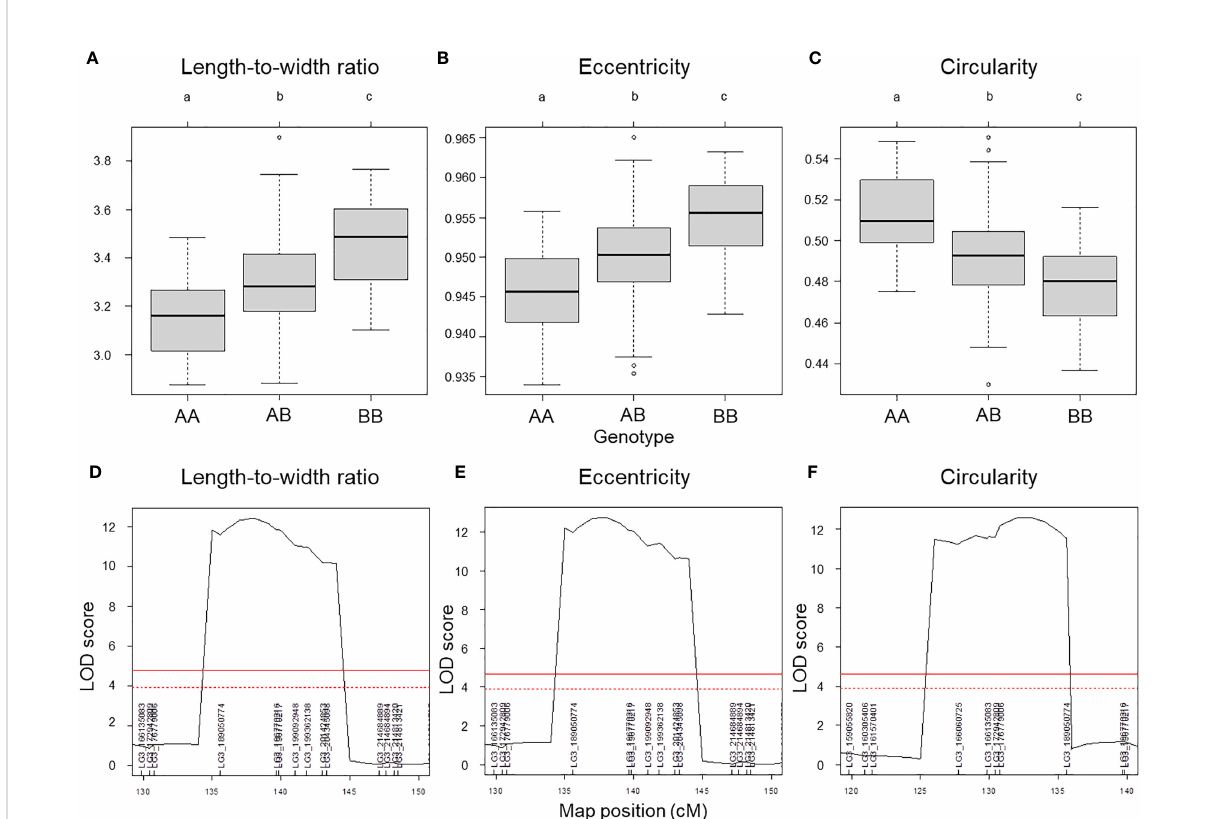
FIGURE 3 QTL mapping results for selected seed morphology traits. (A – C) Phenotypic difference for the traits length-to-width ratio (A) , eccentricity (B) and circularity (C) between the three possible genotypes at three major QTLs with high LOD scores. (D – F) QTL peaks with LOD scores at each locus. Different lowercase letters represent signi fi cant differences ( P <